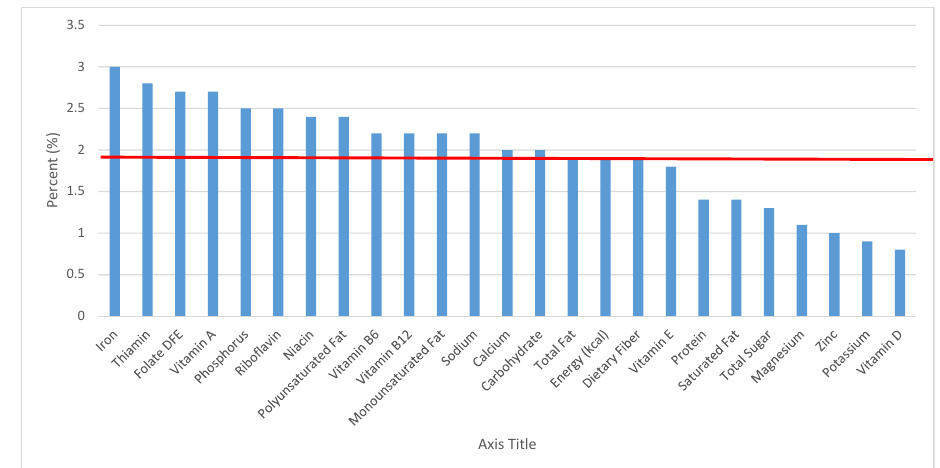
Figure 25. Quick breads and bread products as sources of energy and nutrients for adolescents 14–18 years old ( N = 1508, daily intake data): DFE = Dietary Folate Equivalents; solid red line represents percentage of energy (kcal) provided in the diet relative to nutrients—nutrients above the red line show the grain food’s contribution to nutrient density.